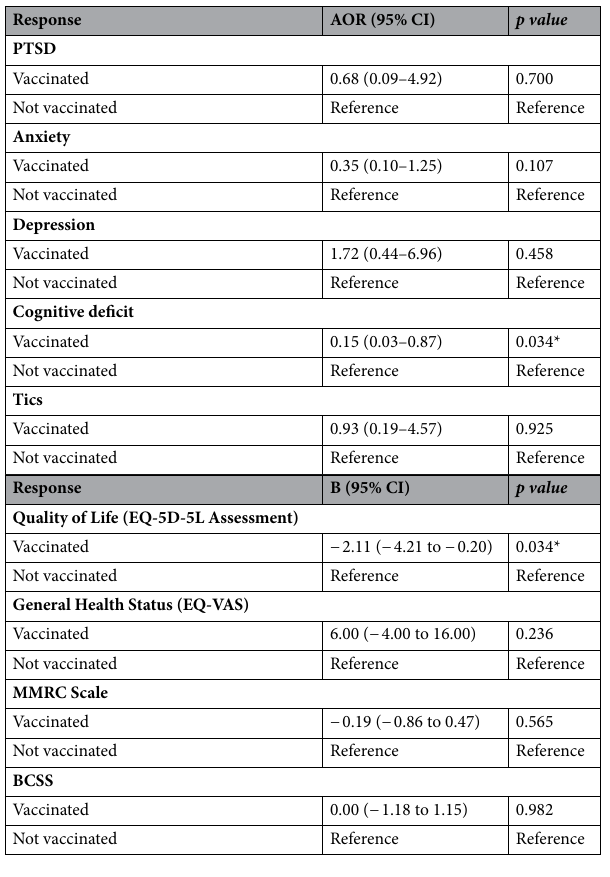
Table 4. Multivariate logistic regression of COVID-19 vaccination status and PACS. This table describes the differences in PACS occurrence among COVID-19 survivors between vaccinated and nonvaccinated patients. P value < 0.05. PTSD Posttraumatic stress disorder, VAS Visual Analogue Scale, EQ-5D-5L EuroQol 5-dimension 5-level assessment, MMRC Modified Medical Research Council scale, BCSS Breathlessness, Cough, and Sputum